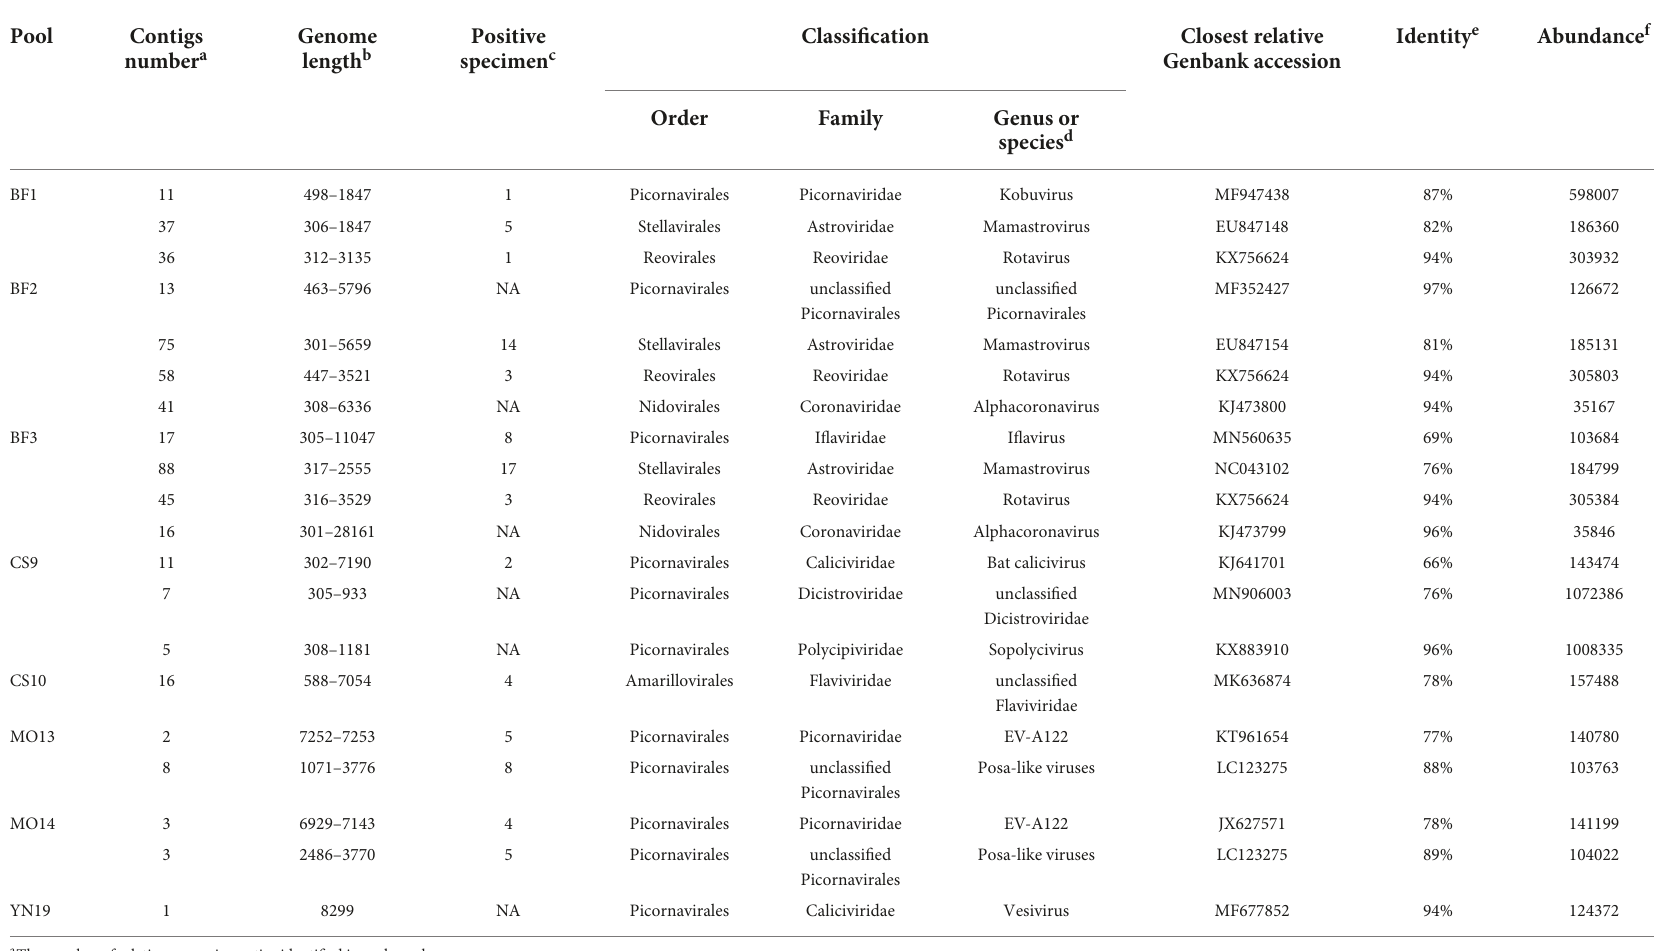
TABLE 2 The potential viruses that infect the eukaryotic organisms detected in each